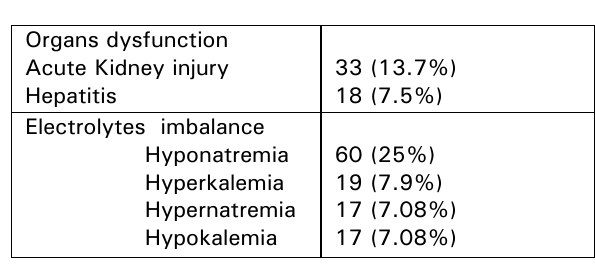
Figure 2. Prevalence of co-morbidities in patients with heart